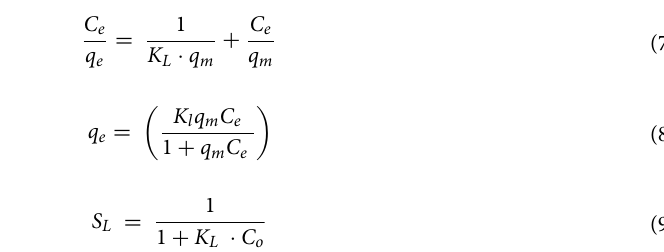
Figure 3. ( a ) NLPFO, ( b ) LPFO, ( c ) NLPSO, and ( d ) LPSO fittings for the adsorption of MF and PA on WTC and